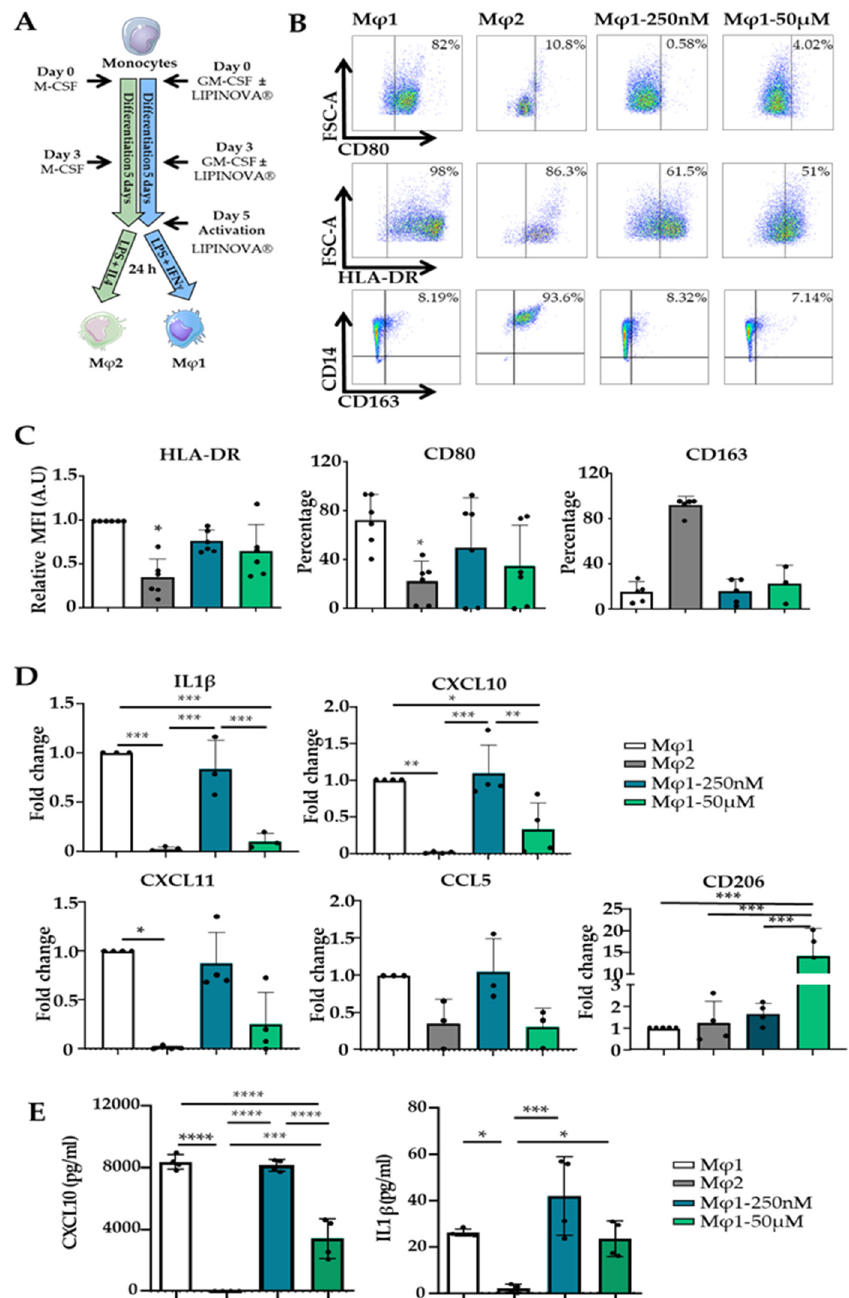
Figure 3. LIPINOVA ® modulates the expression of M φ 1 and M φ 2 markers in vitro. ( A ) Differentia- tion scheme of monocytes using GM-CSF, LPS, and IFN ɣ to obtain M φ 1, and M-CSF, LPS, and IL4 to obtain M φ 2. LIPINOVA ® was added on days 0, 3, and 5. ( B ) Representative dot plots of HLA- DR+, CD80+, and CD163+ cells assessed by flow cytometry on day 6 after differentiation.( C ) Graphs representing flow cytometry quantification of M φ 1 (white), M φ 2 (grey), and M φ 1 incubated with LIPINOVA ® at 250 nM (cyan) or 50 μ M (green). Data are represented as mean ± SD of five inde- pendent experiments. ( D ) Gene expression levels of IL1 β , CXCL10, CXCL11, and CD206 quantified by qPCR in M φ 1 (white), M φ 2 (grey), and M φ 1 incubated with 250 nM (cyan) or 50 μ M (green) LIPINOVA ® during differentiation. ( E ) ELISA assay to assess CXCL10 and IL1 β production by M φ 1 (white), M φ 2 (grey), and M φ 1 incubated with 250 nM (cyan) or 50 μ M (green) LIPINOVA ® at day 6 of differentiation. Data are represented as mean ± SD of four independent experiments. Each dot represent an independent experiment. One-way ANOVA was used for statistical analysis; * p < 0.05, ** p < 0.01, *** p < 0.001, and **** p < 0.0001.